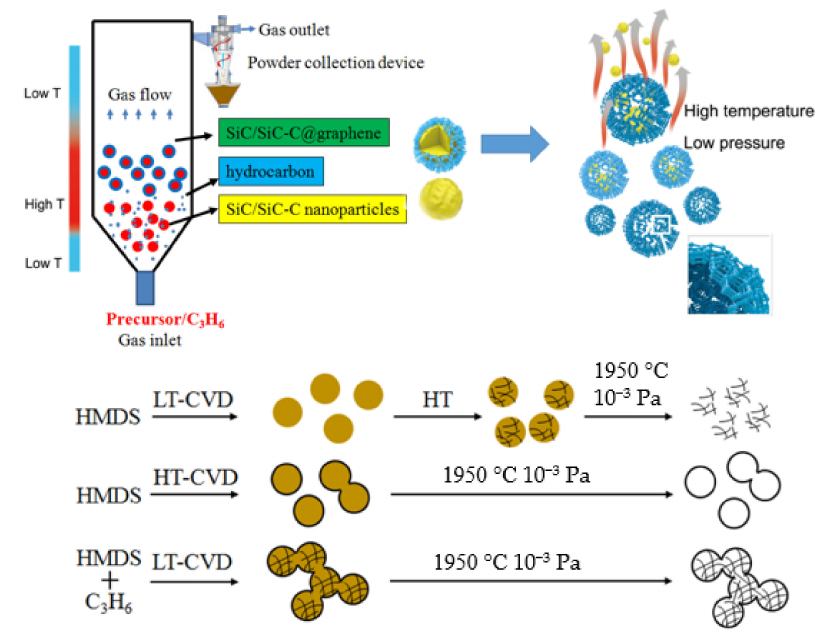
Figure 1. Schematic diagram of the preparation process for the 3DGNs by fluidized bed chemical vapor deposition combined with subsequent heat treatment.